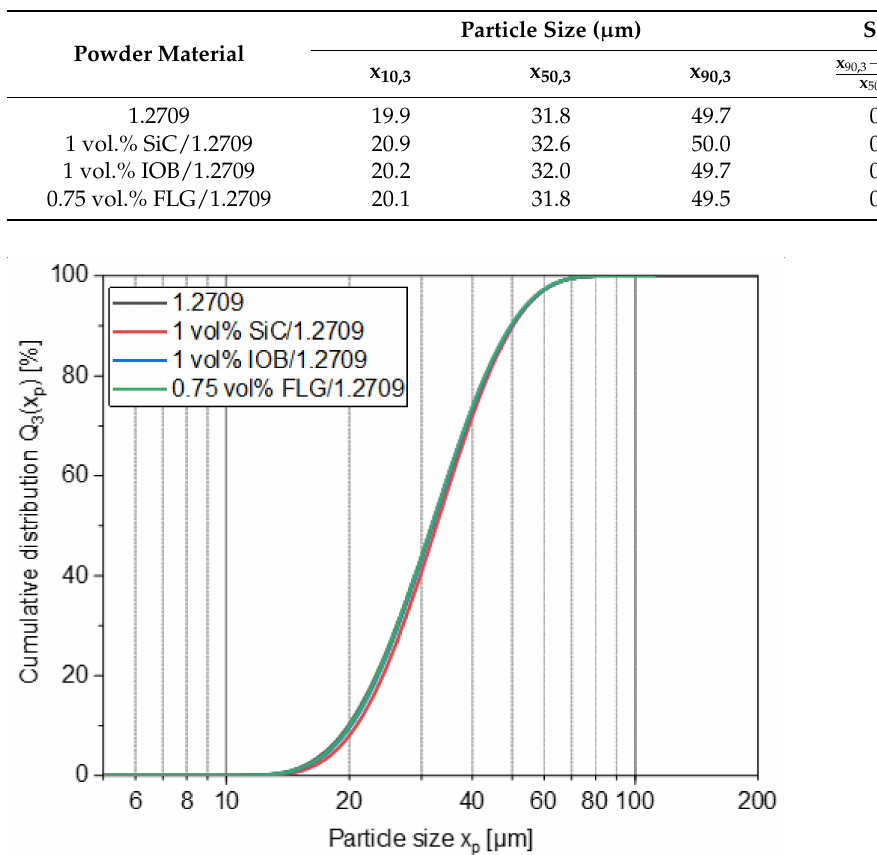
Figure 4. Particle size distribution of feedstock powder 1.2709 and nanoparticle